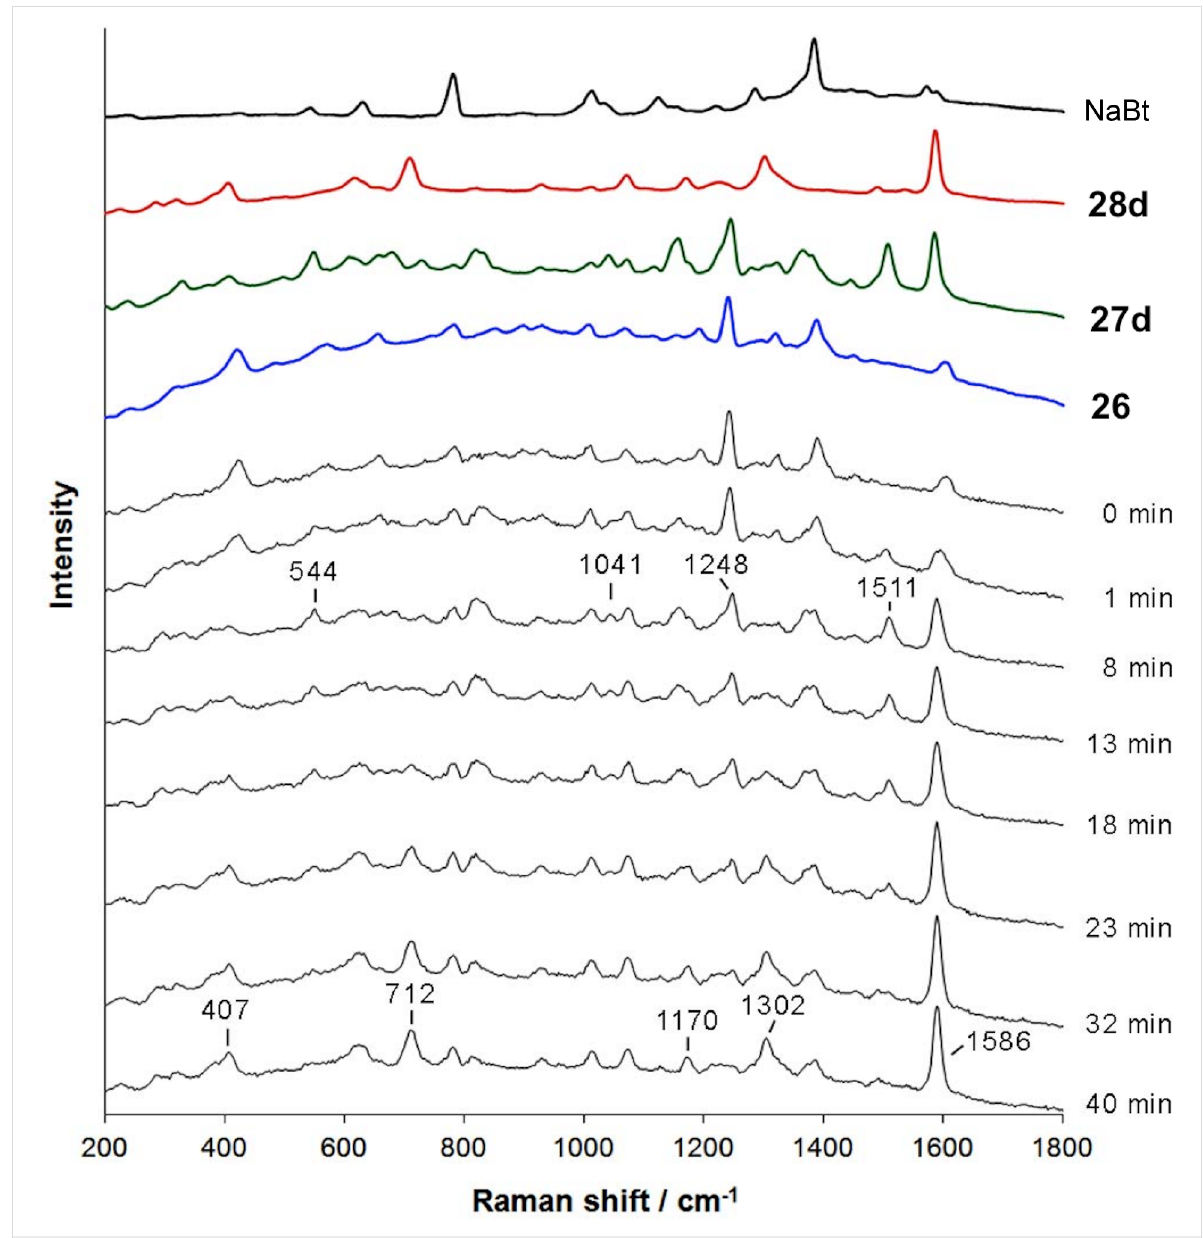
Figure 4: In situ Raman spectroscopy monitoring the synthesis of thiourea 28d in the solid-state. N -Thiocarbamoyl benzotriazole 27d was identified as the intermediate, with the characteristic bands at 544, 1041, 1248, and 1511 cm − 1 appearing ca. 2 min into milling and disappearing with the for- mation of 28d